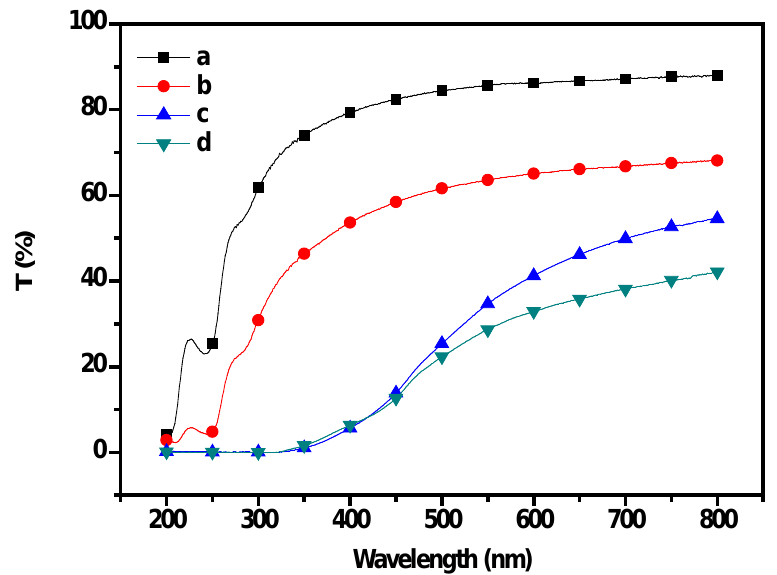
Figure 3. UV transmittance spectra of composite films having: ( a ) only CP, ( b ) 1:0.5 CP/PU, ( c ) 1:1 CP/PU, and ( d ) 1:1 CP/PU with 10 wt% curcumin. Table 1. UV-transmittance, thickness, and color values of the CP/PU/curcumin composite films.